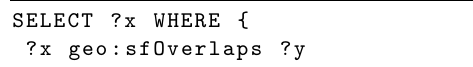
Figure 3. Example of a spatial qualitative query